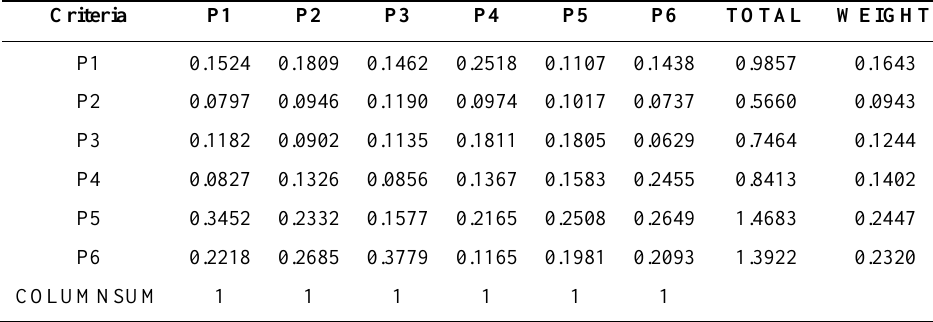
Normalization of Pairwise Comparison of Tax Avoidance and Compliance Dimension